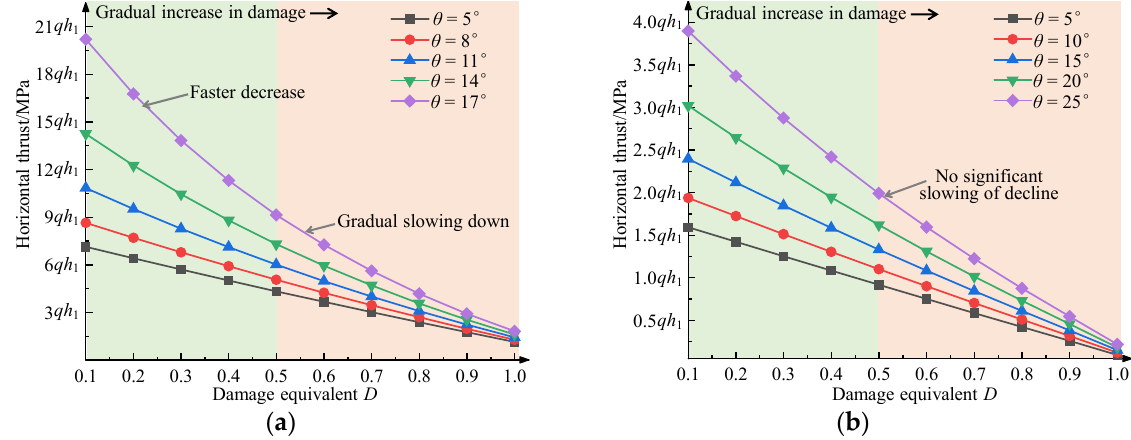
Figure 7. Influence of damage degree on horizontal thrust between key blocks. ( a ) First fracture of the damaged main roof ( b ) Periodic fracture of the damaged main roof.